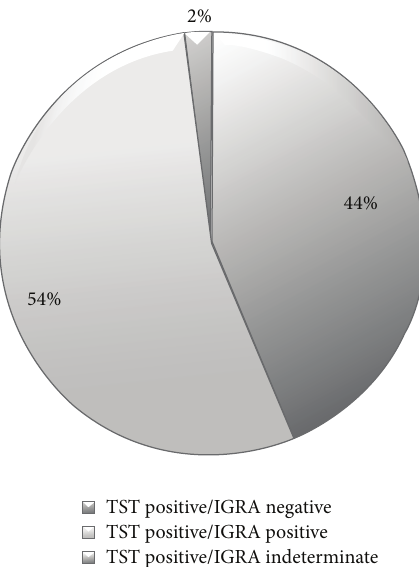
Figure 1: IGRA results following positive TSTs ( 𝑁 = 203 ).